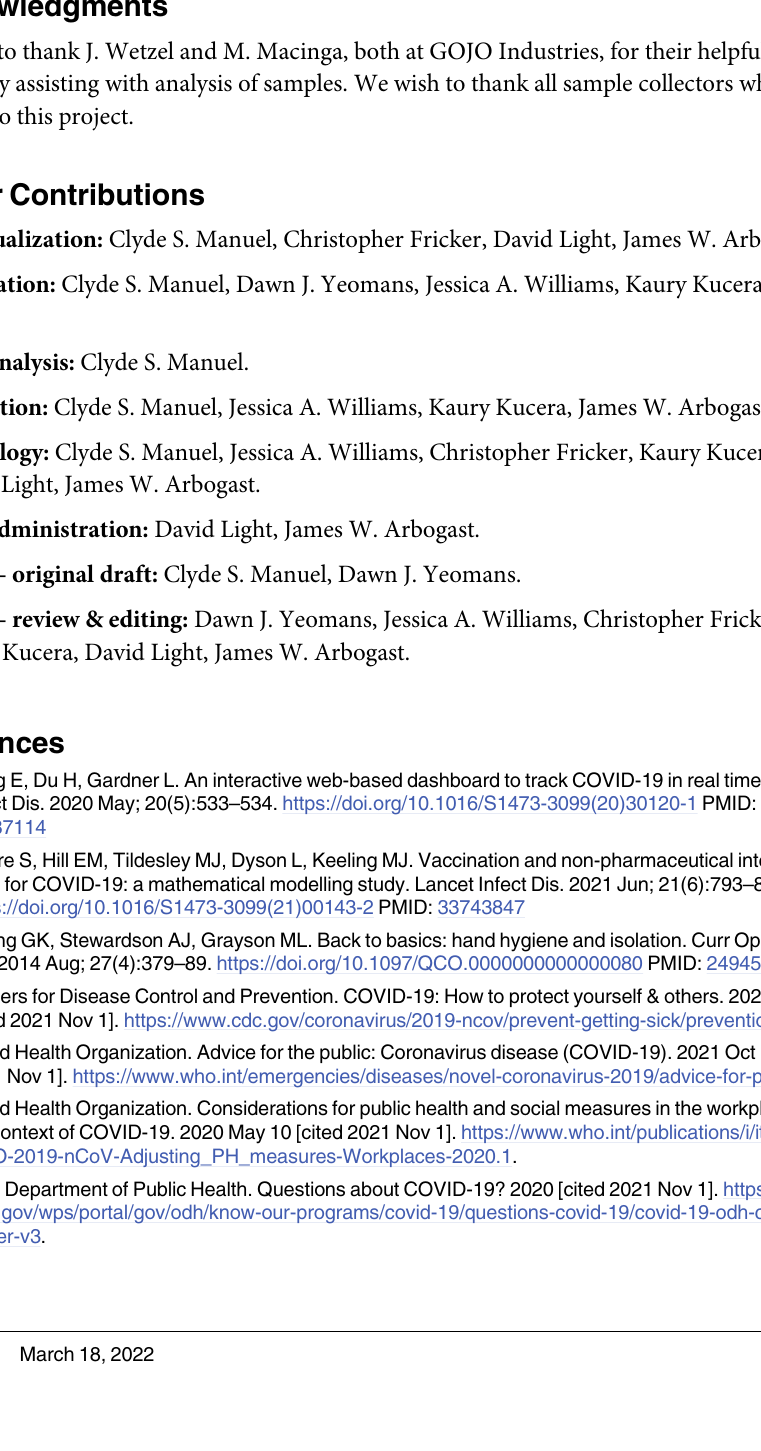
S1 Fig. Impact of ABHS format type on evaporation rates. S1 Table. Summary of